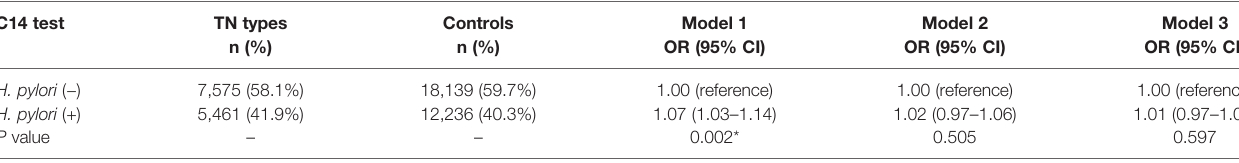
TABLE 2 | OR for the association between H. pylori infection and the risk of TN